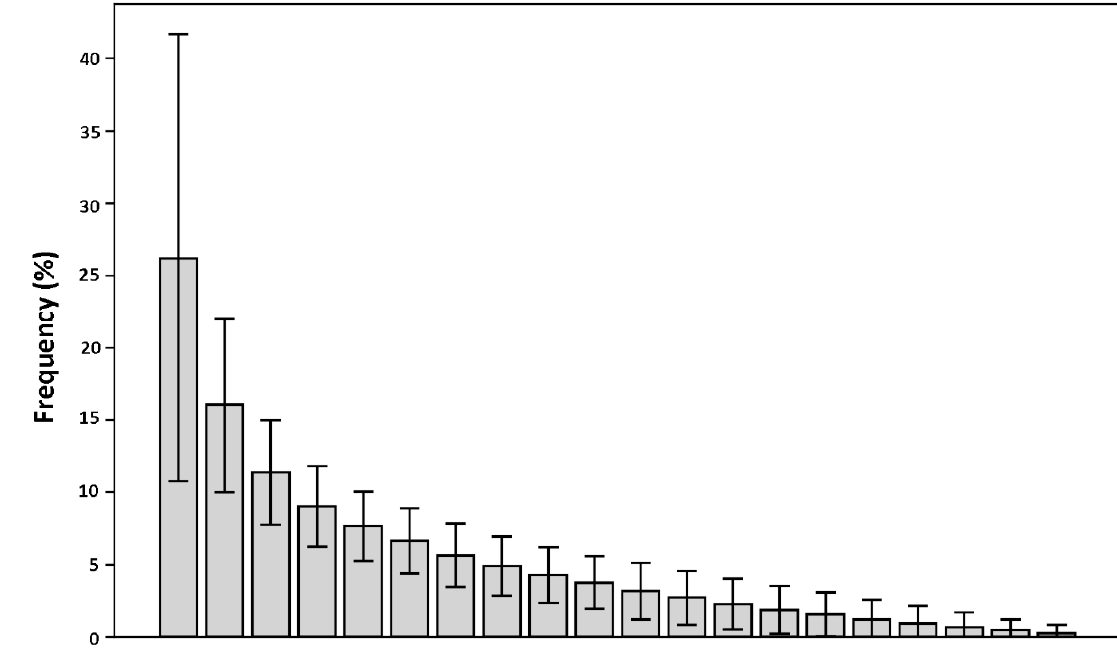
Figure 4. Distribution of the average residue-fragment contact frequencies. The error bars indicate the standard deviation (see text for details).